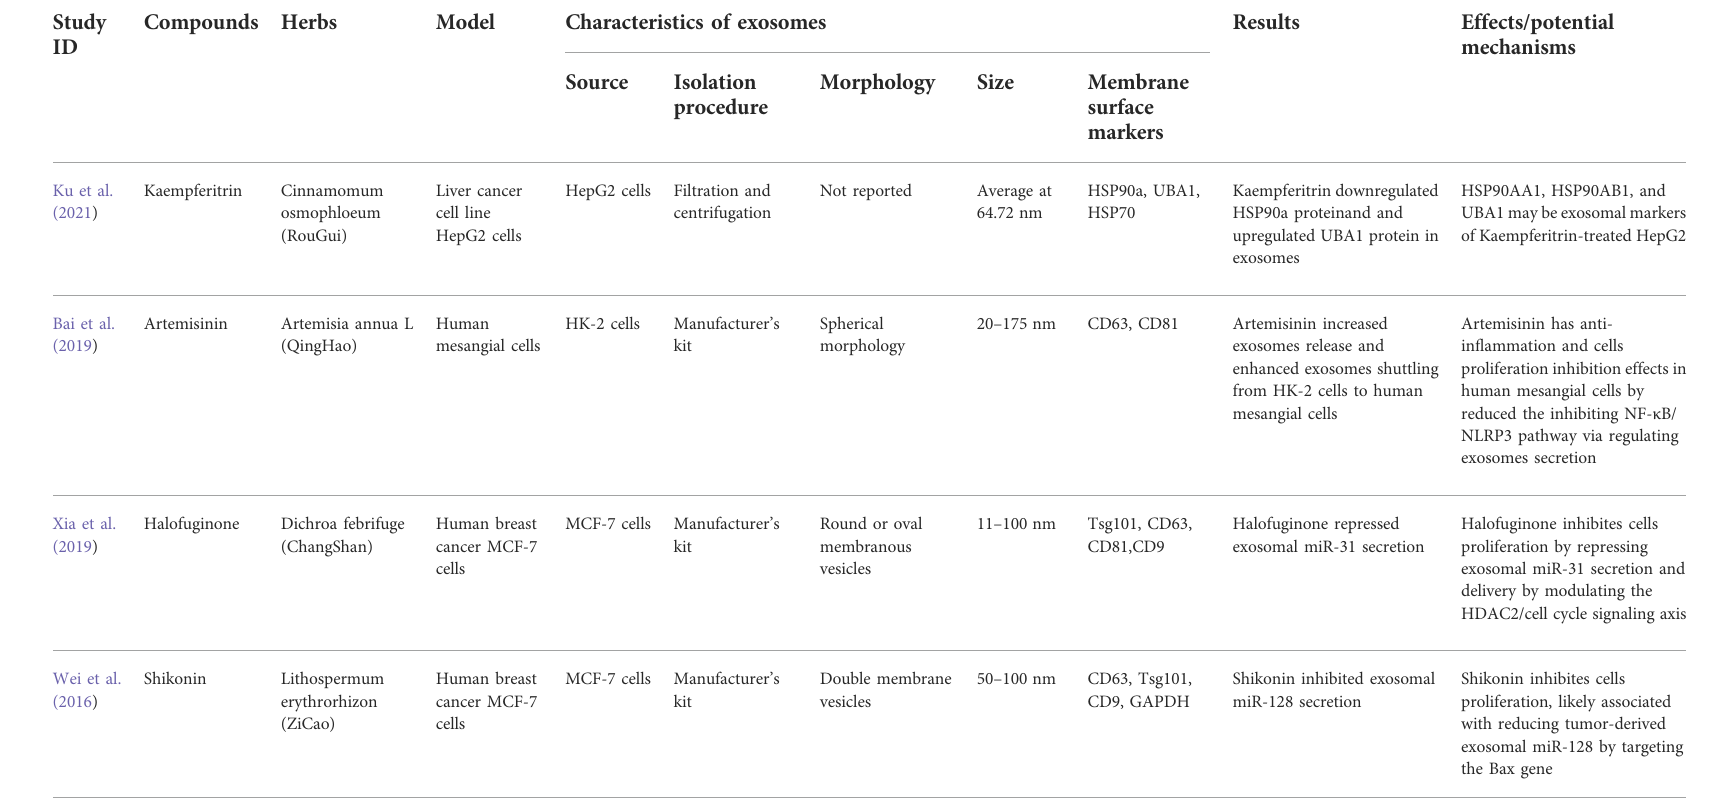
TABLE 2 Exosome modulators from compounds isolated from traditional Chinese